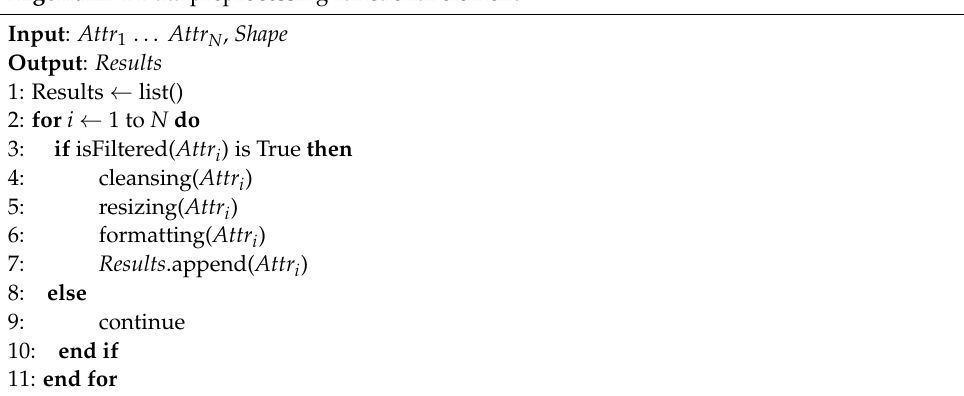
Algorithm 1 Data preprocessing functional element